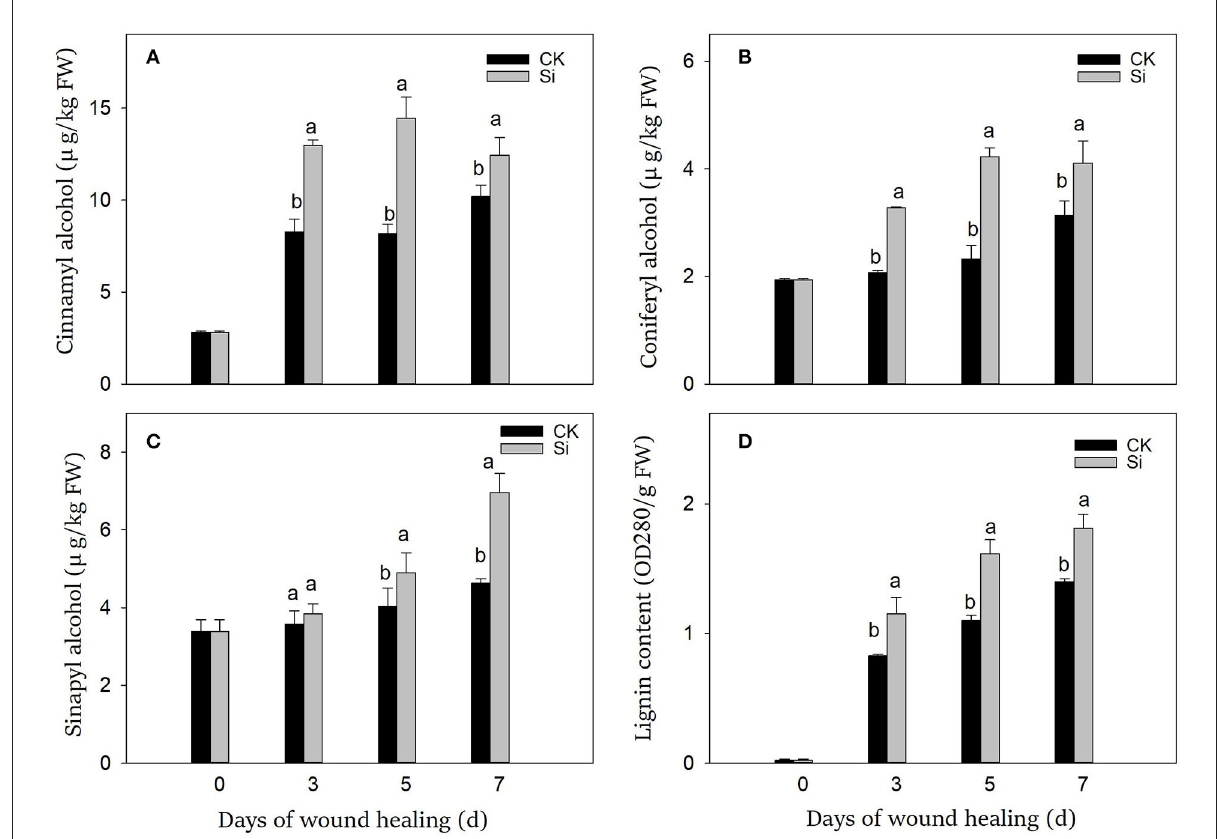
FIGURE4 Effect of sodium silicate treatment on the contents of lignin precursors and lignin. The contents of cinnamyl alcohol (A) , coniferyl alcohol (B) , sinapyl alcohol (C) , and lignin (D) . Vertical bars indicate the standard error of three replicate assays. Columns with different letters at each time point are significantly different (LSD, P <